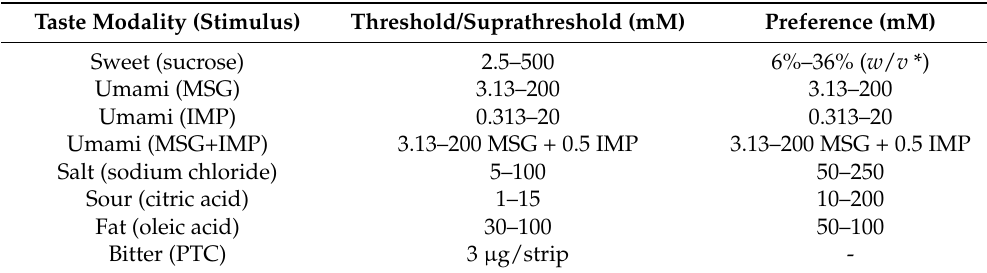
Table 1. Range of tastant concentrations used for each psychophysical